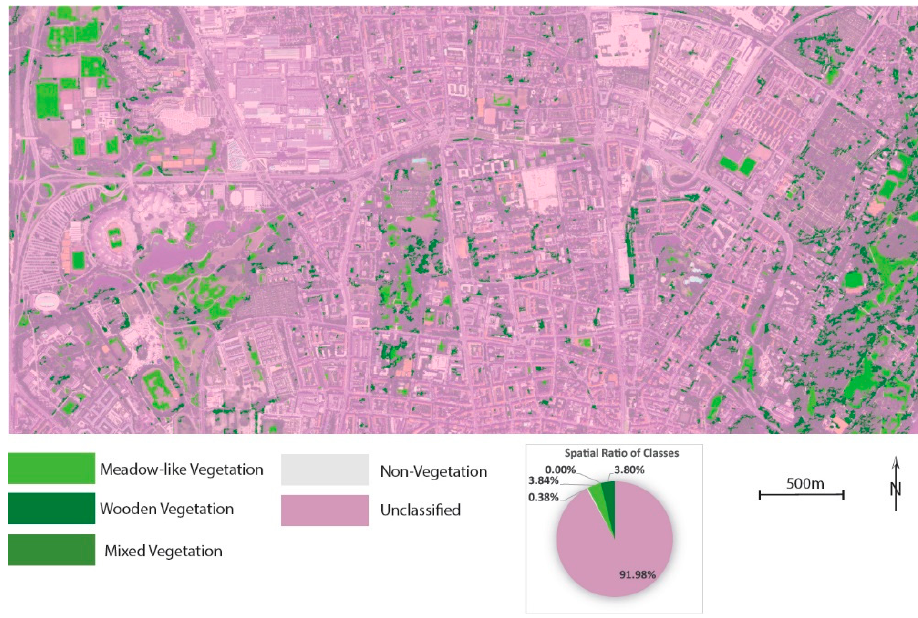
Figure 6. Defuzzification of objects being a doubtless member of their BCR ( μ (cid:2868) = 1.0 and μ (cid:2869) = 0.0 ). of WV-2 scene of Munich.